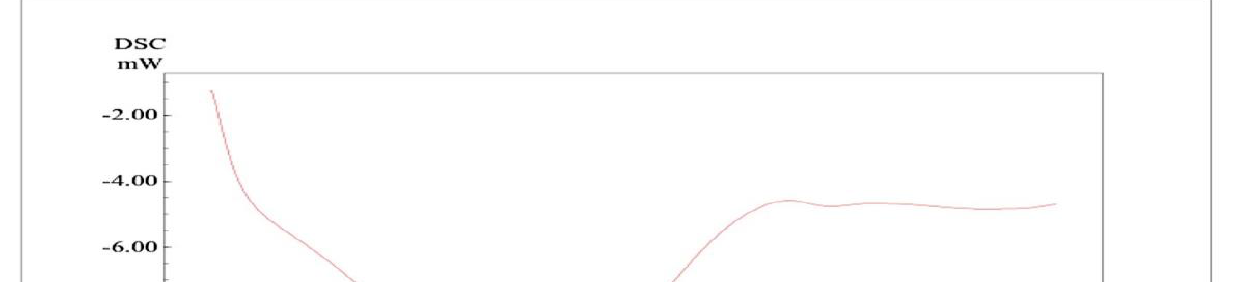
Figure 16. DSC thermogram of pure domperidone.